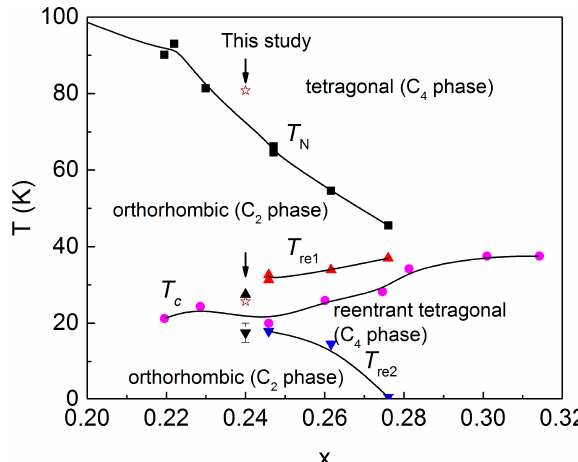
Figure 3. Composition–temperature phase diagram of reentrant C 2 - C 4 - C 2 transformation in (Ba 1 − x K x )Fe 2 As 2 (after Refs. [7,8]). The data of this study are shown with stars and highlighted by arrows. They are in reasonable agreement with the diagram, within possible error bars of composition